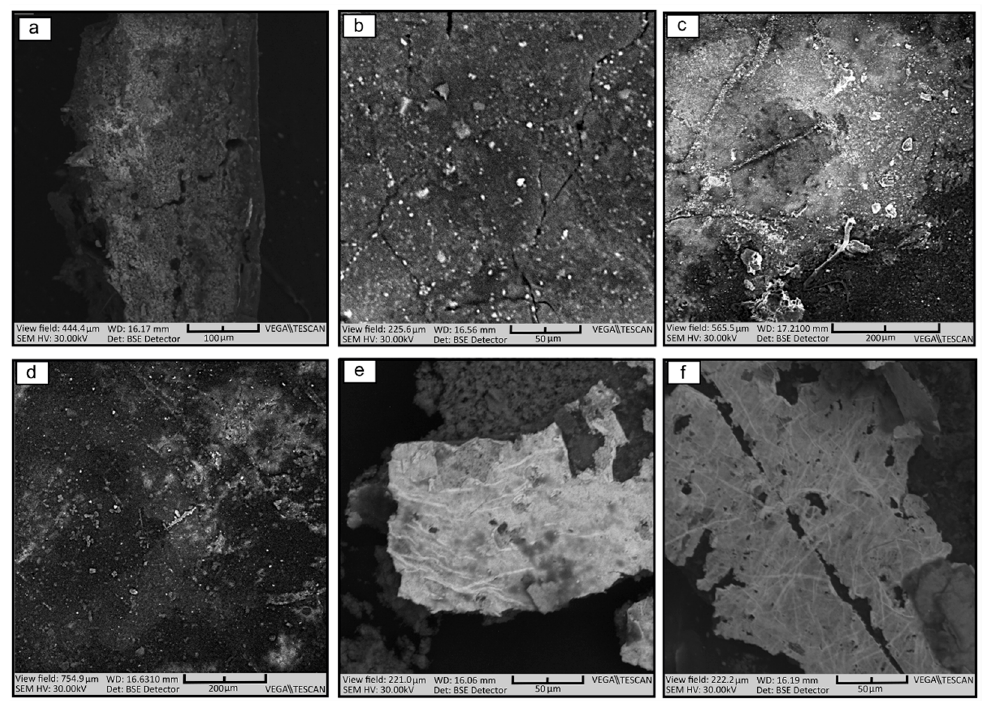
Figure 11. SEM microphotographs in BSE (200–1000×): ( a ) Preparation; ( b ) Varnish and embedded dirt; ( c ) Red pigment; ( d ) Blue pigment; ( e ) Silver foil with bronze marks; ( f ) Gold foil with bronze marks.